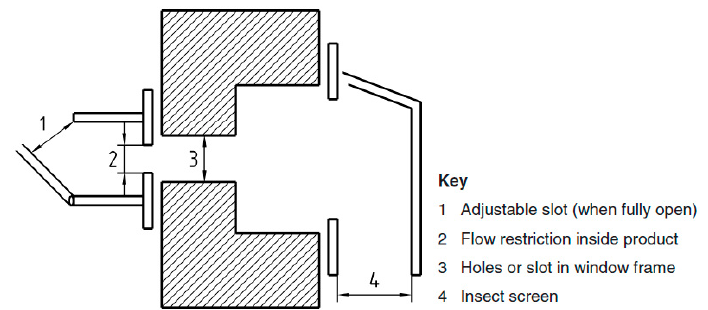
Figure 10. Geometrical free area [59].